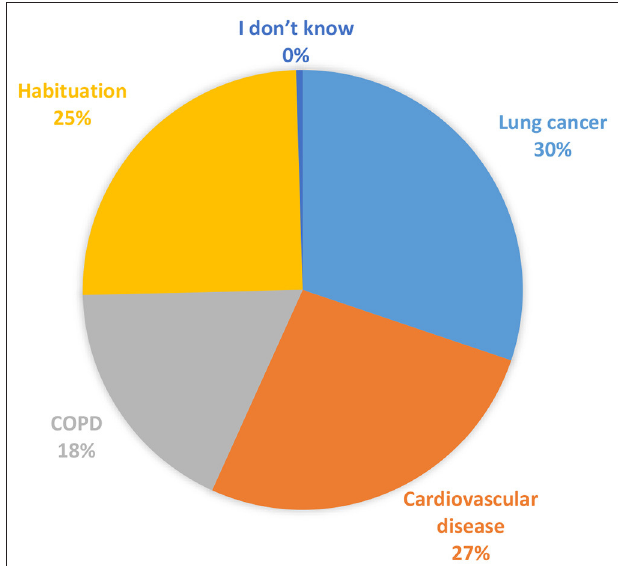
FIGURE 1 | The most important hazards faced by the smokers.